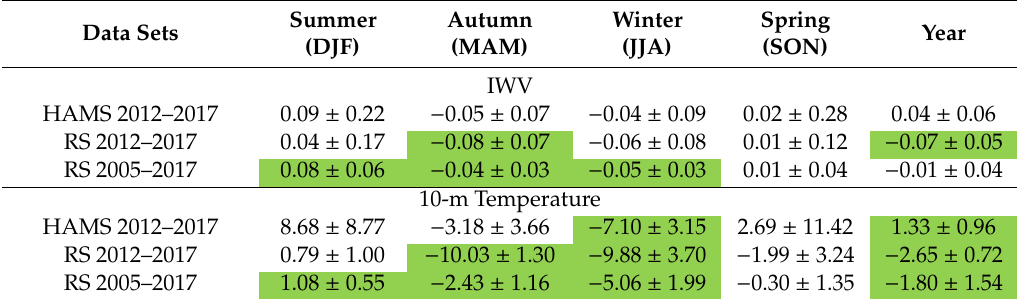
Table 1. Decadal trends in IWV (kg m − 2 dec − 1 ) and in 10-m temperature (K dec − 1 ) along with 1- σ error for HAMSTRAD (‘HAMS’) and radiosondes (‘RS’), based either on seasonally-or annually-averaged data over 2012–2017, and over 2005–2017 for radiosondes only. Significant trends are highlighted in